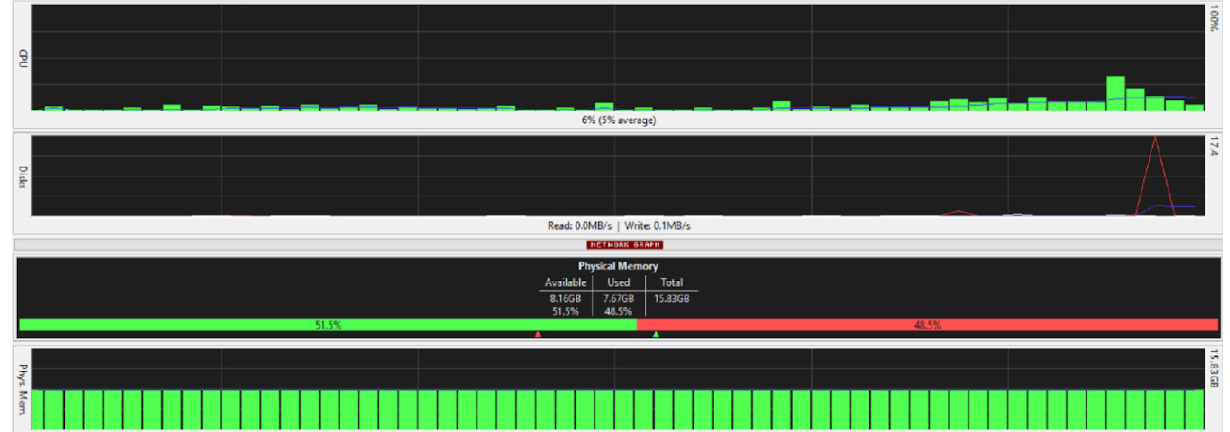
Figure 25. Running the monitoring tool before the application in process (block creator).